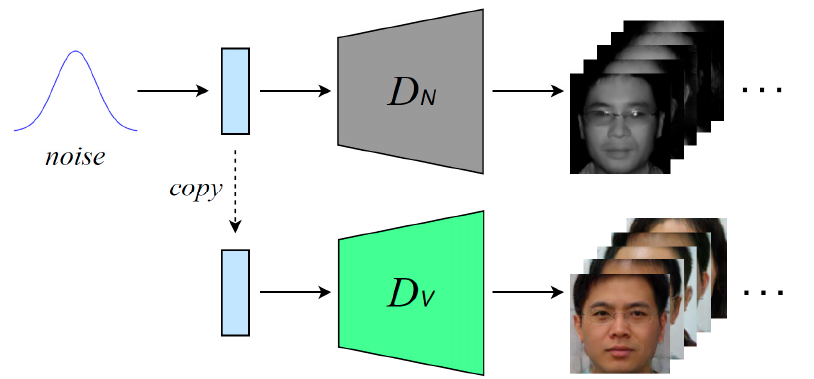
Figure 5. The process of generating well-aligned near infrared-visible (NIR-VIS) images with the same identity.